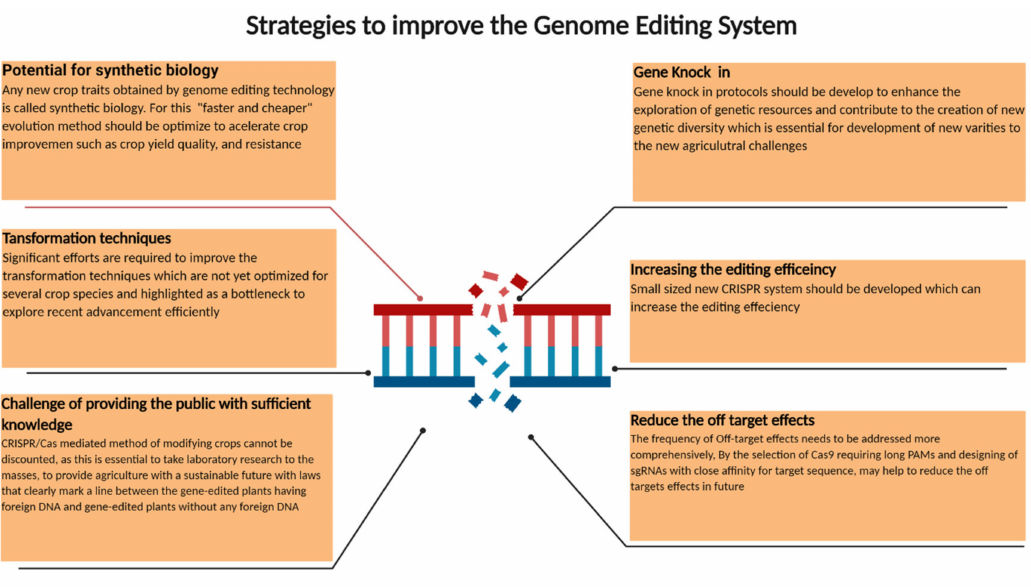
Figure 7. The illustration represents the major strategies aimed at improving the genome-editing